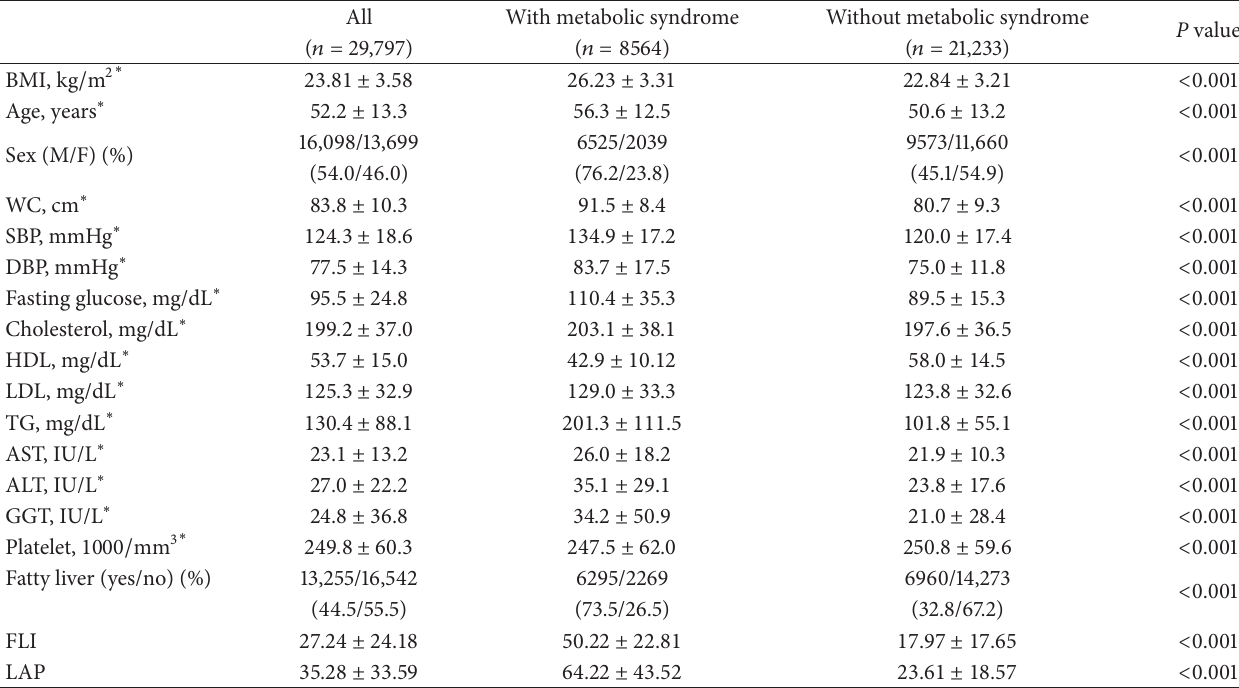
Table 1: Characteristics of subjects with and without metabolic